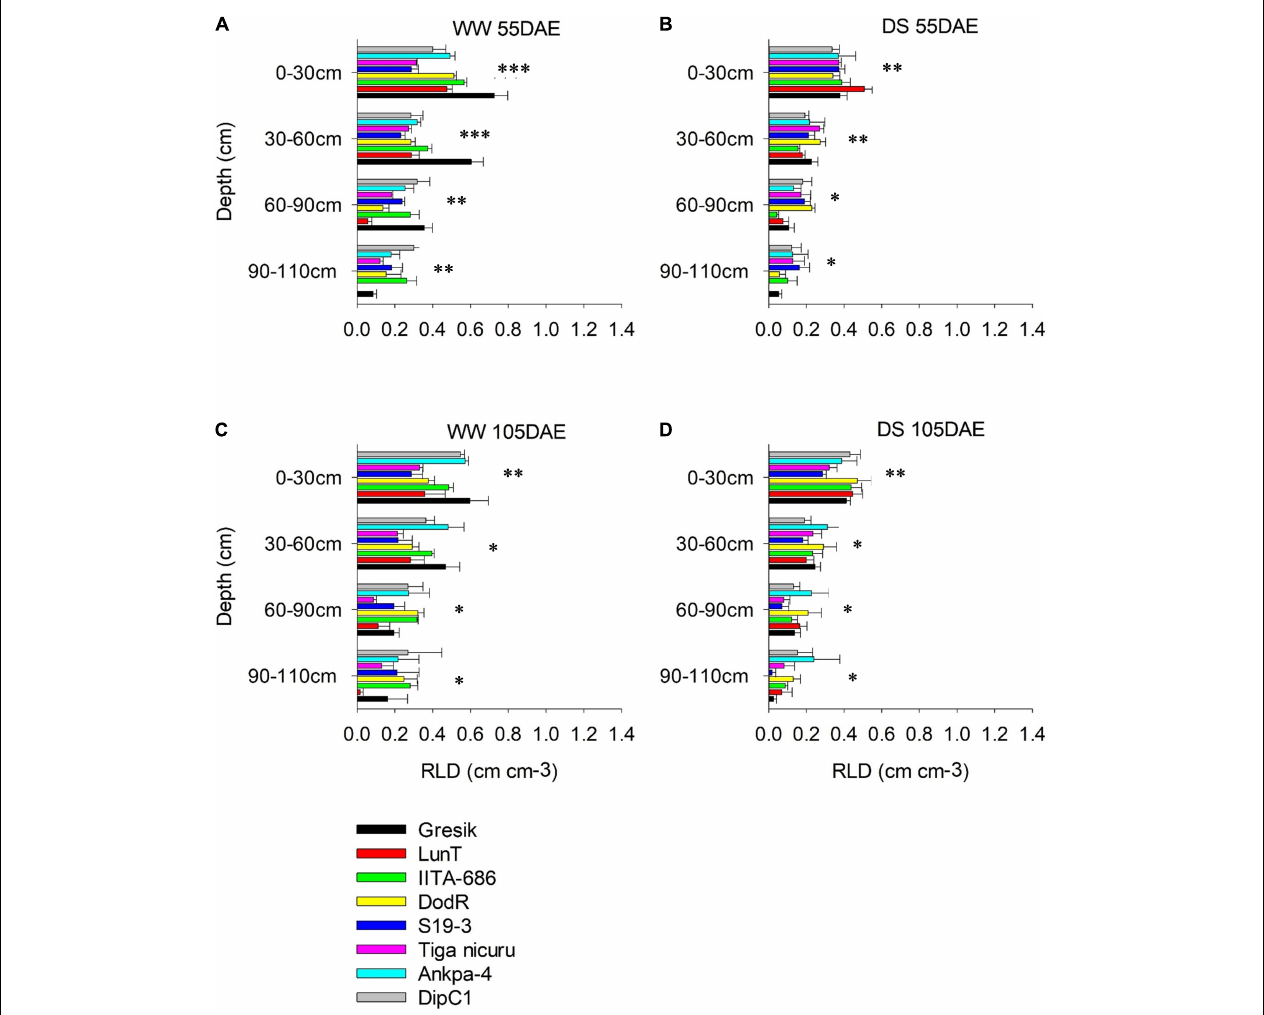
FIGURE 6 | Root length density (RLD) of eight bambara groundnut genotypes at different soil depths grown in soil-filled PVC columns in the 2018 season (A,B) WW and DS at 55 DAE, respectively. (C,D) WW and DS at 105 DAE, respectively. Mean ± SE values ( n = 3) are shown. Significant differences as follows: ∗ p < 0.05, ∗∗ p < 0.01, and ∗∗∗ p < 0.001; and ns, not significant, among individual